Question: Which visualization type does this figure use?
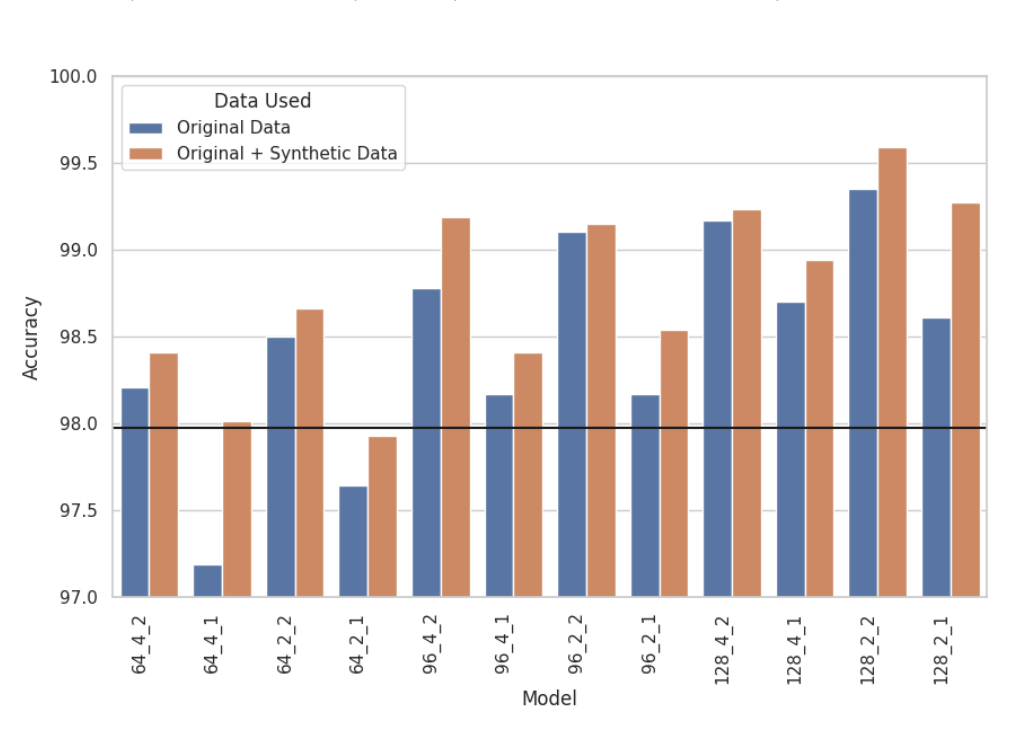
Answer: bar